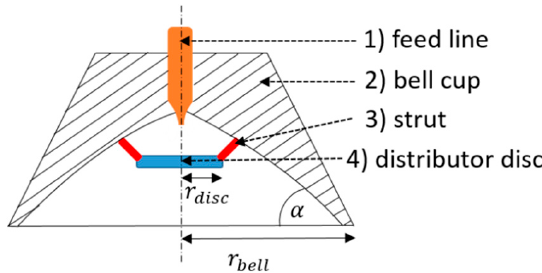
Figure 2. Schematic image of the rotary bell cup.